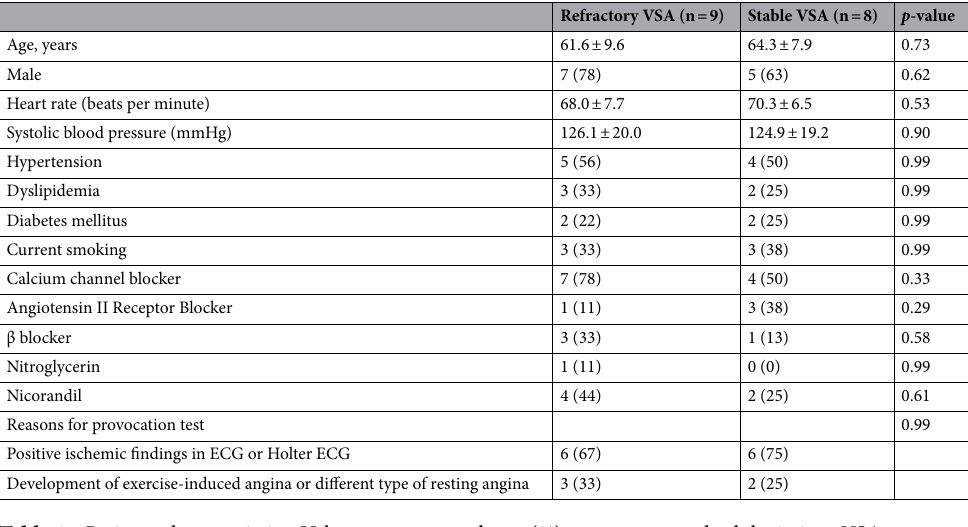
Table 1. Patients characteristics. Values are presented as n (%) or mean ± standard deviation. VSA vasospastic angina.